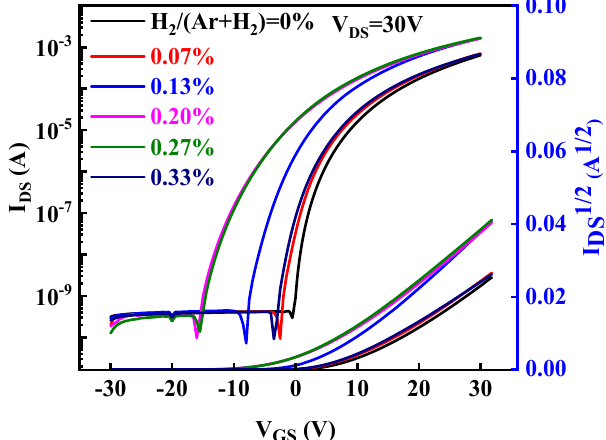
the devices’ performance became worse.